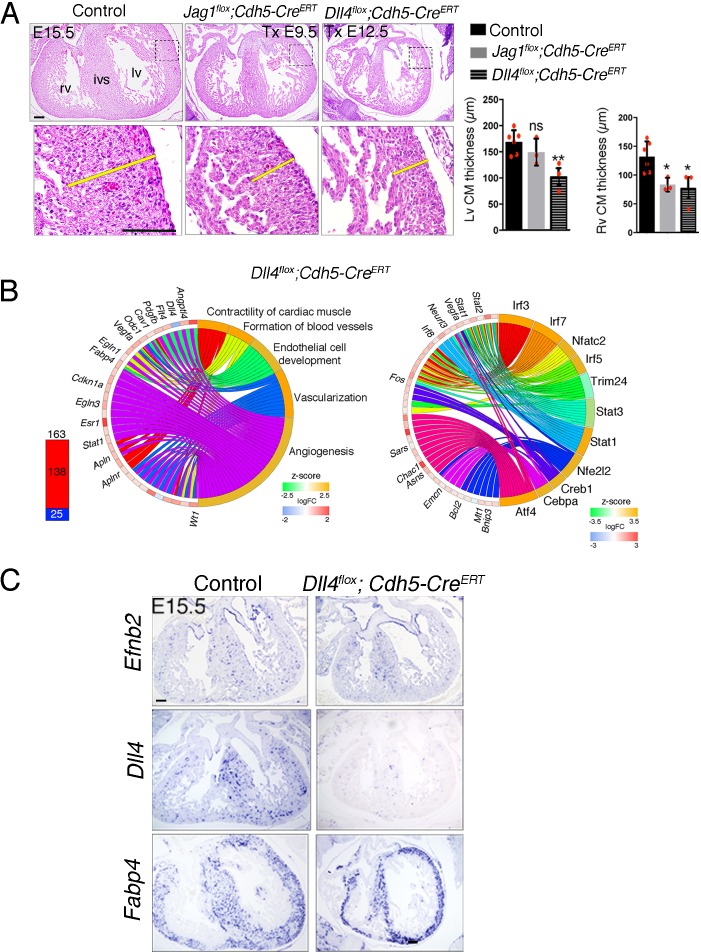
Induced endothelial Jag1 or Dll4 deletion disrupts myocardial growth.(A) H & E staining of transverse sections of E15.5 hearts from control mice, Jag1flox;Cdh5-CreERT2 mice tamoxifen (Tx)-induced at E9.5 and Dll4flox;Cdh5-CreERT2 mice Tx-induced at E12.5. Yellow bars indicate compact myocardium (CM) thickness. Charts show CM thickness in the left ventricle (lv) and right ventricle (rv). ivs, interventricular septum. Data are mean ± s.d. (n = 6 control embryos and 3 mutant embryos). *p<0.05, **p<0.01, 01 by one-way ANOVA with the Dunnett multiple comparison tests; n.s., not significant. (B) Transcriptome profiling of Dll4flox;Cdh5-CreERT hearts at E15.5. Left, total number of differentially expressed genes identified by RNA-seq (BH adjusted p<0.05; abs(logFC)>0.5) in E15.5 Dll4flox;Cdh5-CreERT hearts. Numbers indicate upregulated genes (red) and downregulated genes (blue). Right, circular plot showing representative differentially expressed genes associated to selected IPA functions belonging to the Cardiovascular System Development and Function category. Activation z-score scale: green repression; orange, activation; white, unchanged. LogFC scale: red, upregulated; blue, downregulated; white, unchanged. Right, circular plot showing representative differentially expressed genes depending of selected upstream regulators. Colour codes for z-score and logFC scale as in Left . (C) Induced Dll4 deletion disrupts arterial differentiation. ISH for the arterial markers Efnb2, Dll4, and Fabp4 on E15.5 heart sections from control and Dll4flox;Cdh5-CreERTmice tamoxifen-induced at E12.5. Scale bars, 100 μm.